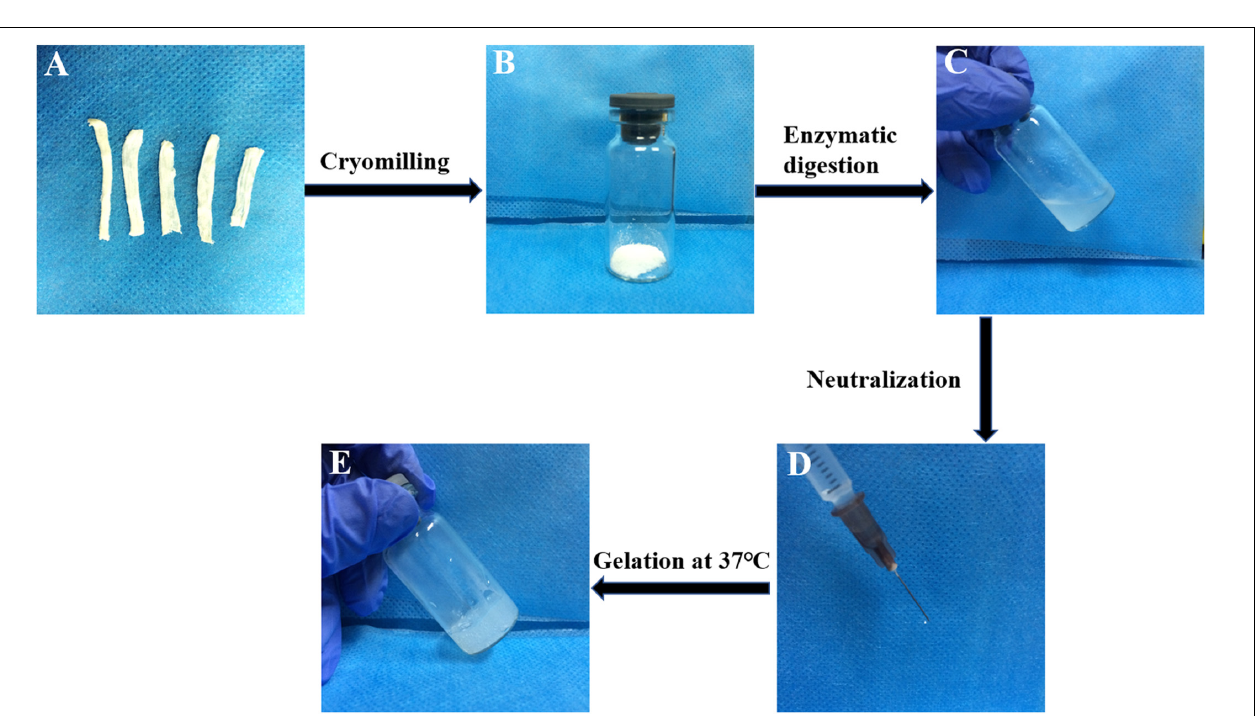
FIGURE 2 | Assessment of decellularization effectiveness. (A) H&E staining and DAPI staining of the NTSs and DTSs. Scale bar = 200 µ m. (B) PicoGreen analysis of residual DNA content in the NTSs and DTSs. *Signifies a P- value of < 0.05 as compared to the NTSs.